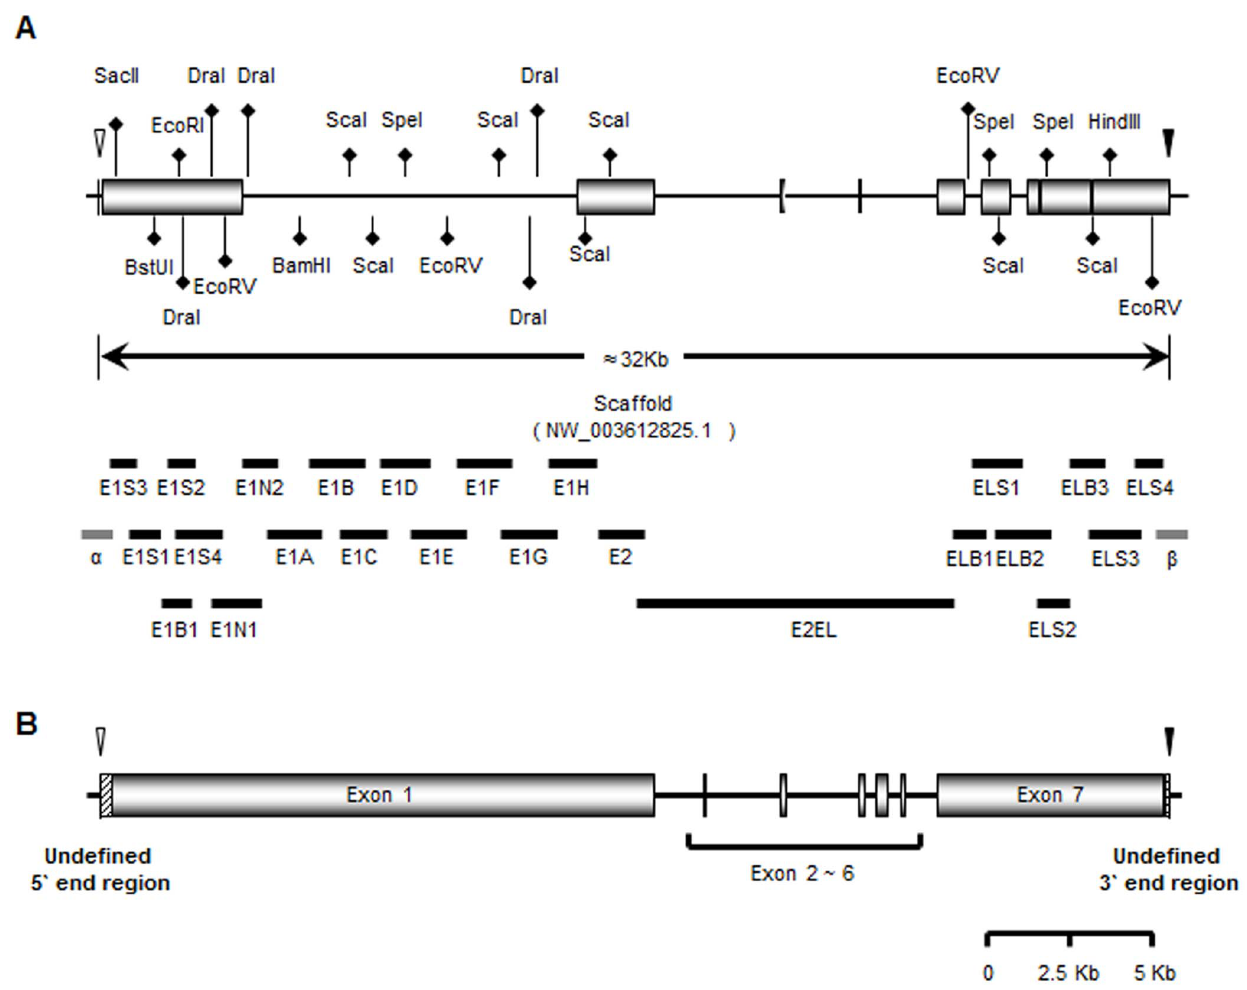
Figure 1. Diagram of the candidate XIST expressing region in the pig. (A) Designed XIST model and primer sets. Candidate XIST ncRNA expression regions on the pig X-chromosome scaffold (NW_003612825.1) determined by BLAST searches are represented by black boxes. Empty and filled arrowheads indicate the 289233 rd and 257103 rd nucleotides of the scaffold, which were aligned with the transcription start site (TSS) and the last sequence of human and bovine XIST, respectively. The designed primer sets are represented as black and gray lines: female-expressed primer sets are represented as black lines and regions that were not expressed in either sex ( a and b ) are represented as gray lines. Restriction enzymes used to digest each amplicon are shown. The diagram is scaled. (B) Diagram of the identified porcine XIST gene model. The porcine XIST expressing region was identified by sequencing. Filled rectangles indicate exons, and boxes with diagonal lines indicate undefined regions. Filled and empty arrowheads indicate candidate 5 9 and 3 9 end regions identified from alignment with human and bovine XIST , respectively. The diagram is